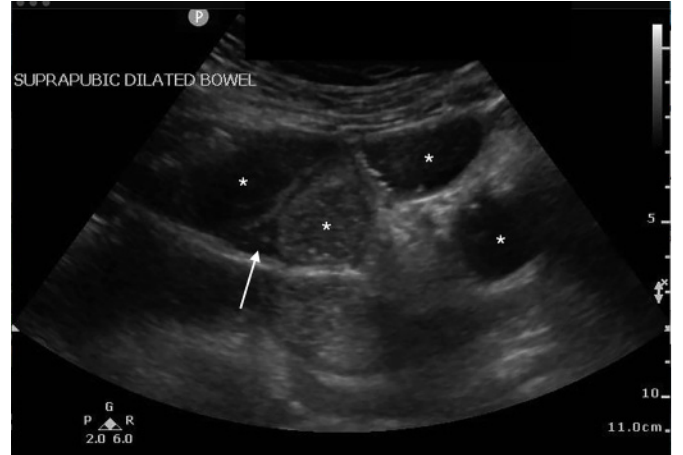
Image 2. Point-of-care ultrasound demonstrating short-axis view of dilated loops of bowel (*) with localized surrounding free fluid (white arrow) consistent with small bowel